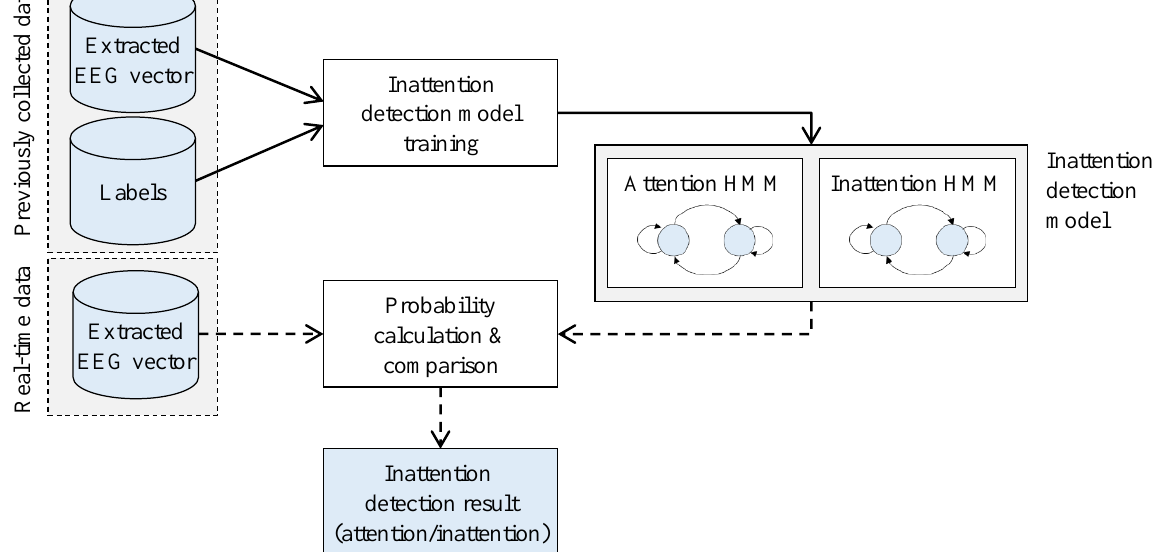
Figure 5. Overview of the inattention detection module using hidden Markov models